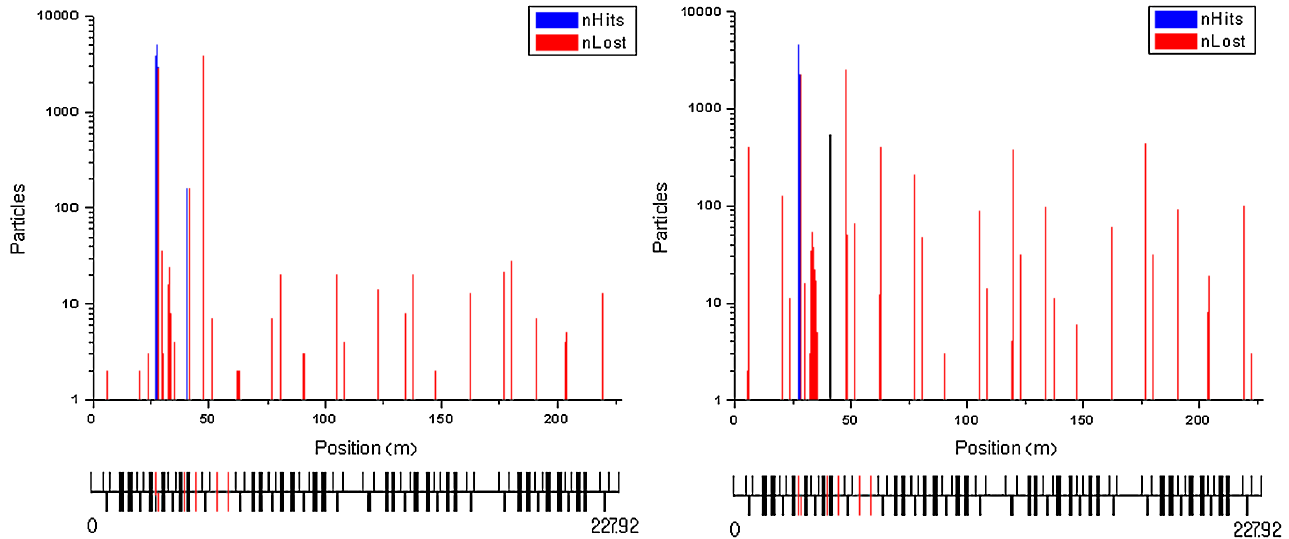
FIG. 13. Distribution of the lost particles along the ring and the hitting particles at the collimators in the CSNS RCS. nHits denotes the number of particles hitting on the collimators and nLost denotes the number of the absorbed particles. A total of 50 000 particles are injected. The simulations cover the energy range of 80–90 MeV corresponding to CSNS-I phase. Left: anticorrelated beam; right: correlated